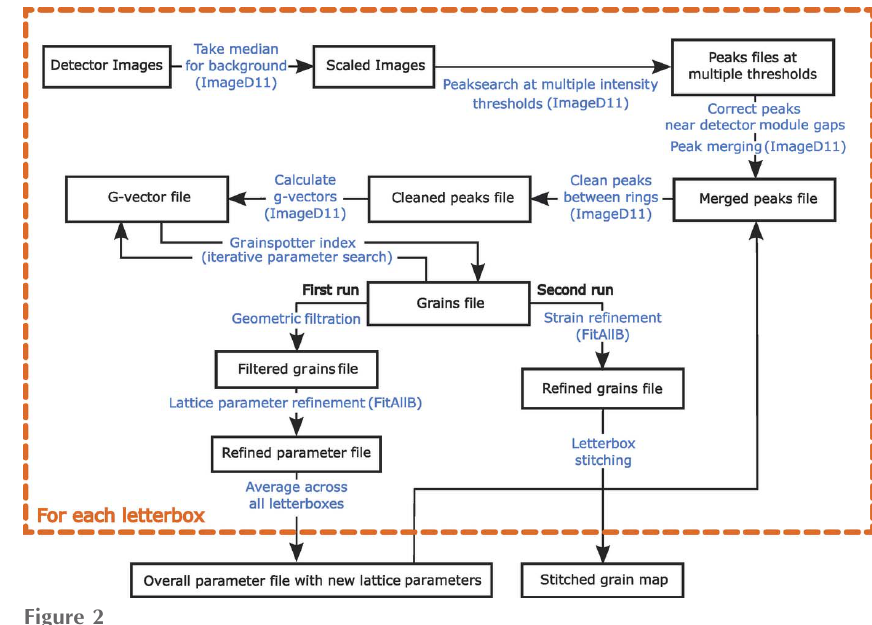
Figure 2 3DXRD in-house data processing flowchart.